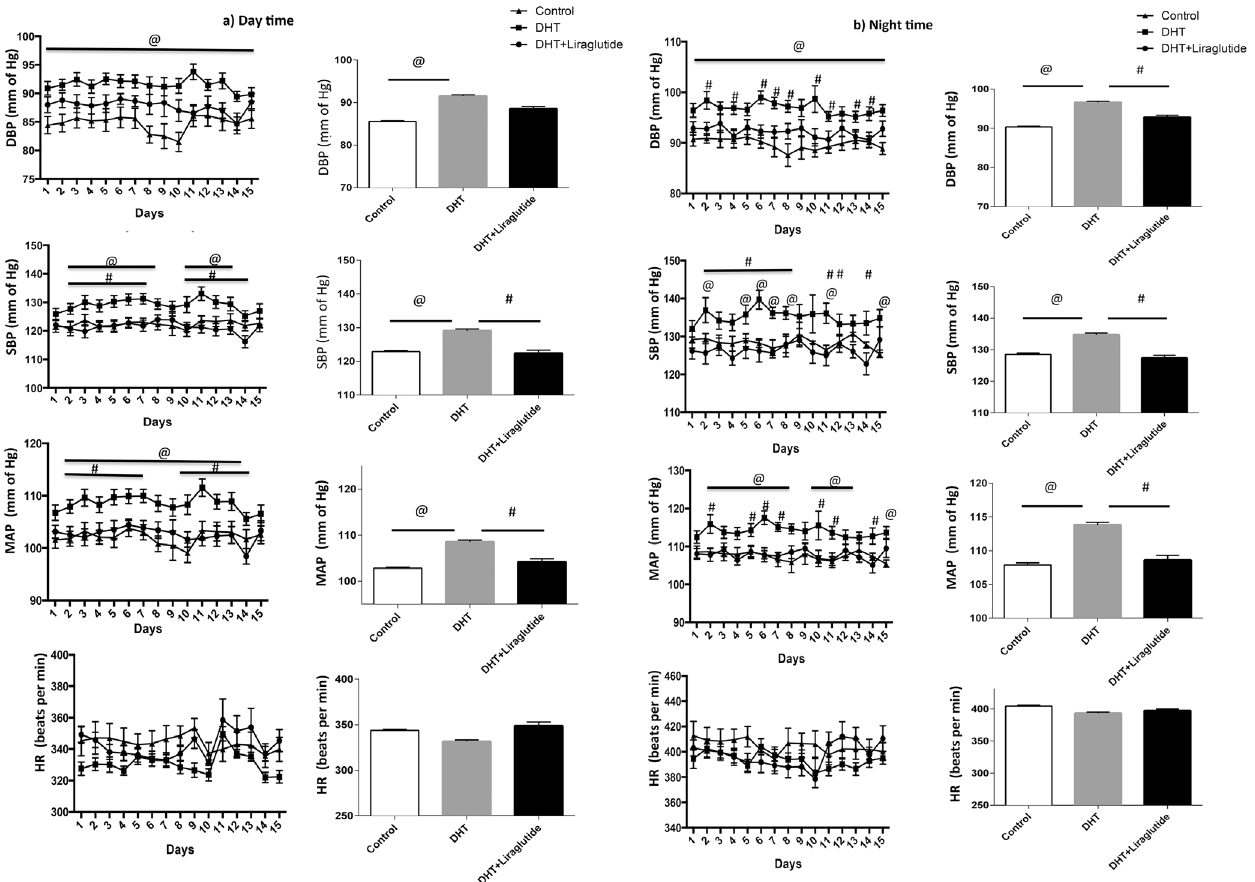
Fig 5. Effect of liraglutide on DHT induced perturbed blood pressure parameters. (Mean ± SEM; mmHg) : a) Day time radiotelemeter data starting at 14 weeks of age: Data is averaged hourly over 15 days. Line graph depicts diastolic blood pressure (DBP; mmHg) (panel A), systolic blood pressure (SBP) (panel B ), mean arterial pressure (MAP; mmHg) (panel C ), and heart rate (HR; beats/min) (panel D ), respectively b) Night time radiotelemeter data starting at 14 weeks of age: Data is averaged hourly over 15 days. Line graph depicts diastolic blood pressure (DBP; mmHg) (panel A), systolic blood pressure (SBP) (panel B ), mean arterial pressure (MAP; mmHg) (panel C ), heart rate (HR; beats/min) (panel D ), respectively. Bar graphs depict average values of BP parameters shown in panels A-D. Significant difference (p < 0.05) between groups is marked as follows: # = DHT vs DHT+ liraglutide @ = DHT vs control.